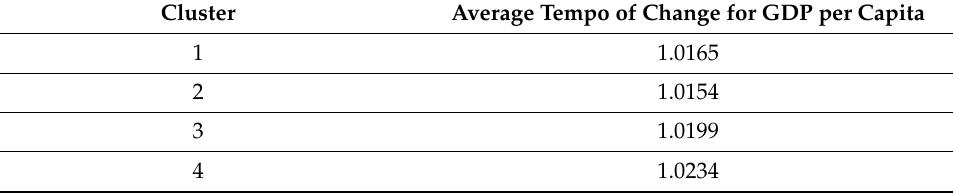
Table 6. Average value of medium-period tempo of change for GDP per capita (US Dollar, 2015) in each cluster.